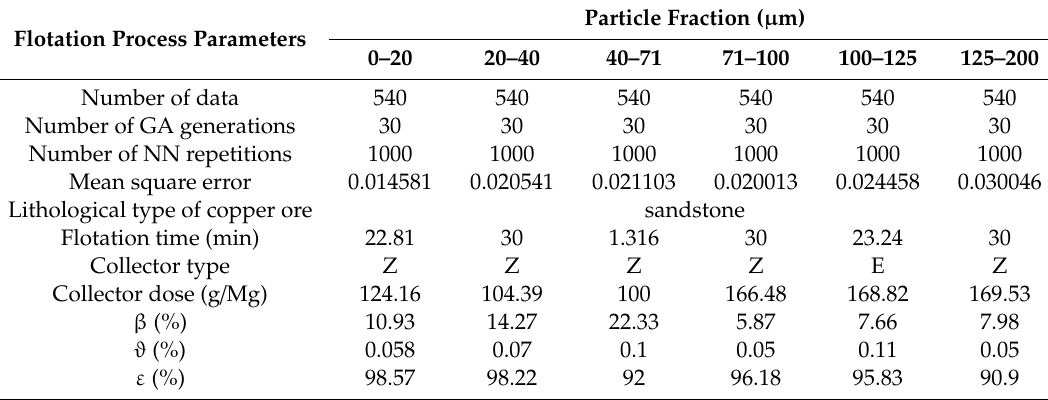
Table 13. A summary of the optimisation results of the flotation process of particular particle fractions from the Lubin-Głog ó w copper ore district in the Denver-type flotation machine (E—aqueous solution of ethyl sodium xanthate, Z—aqueous solution of isobutyl sodium